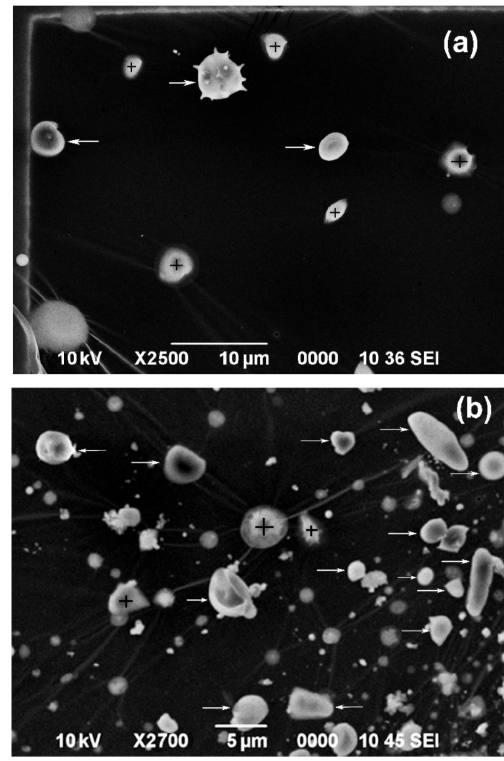
Figure 12. Typical SEIs of PBA particles from stage 4 of the (a) SA4 and (b) SM3 samples. PBA and PBA–SOA mixture par- ticles are marked with ( → ) and ( + ),